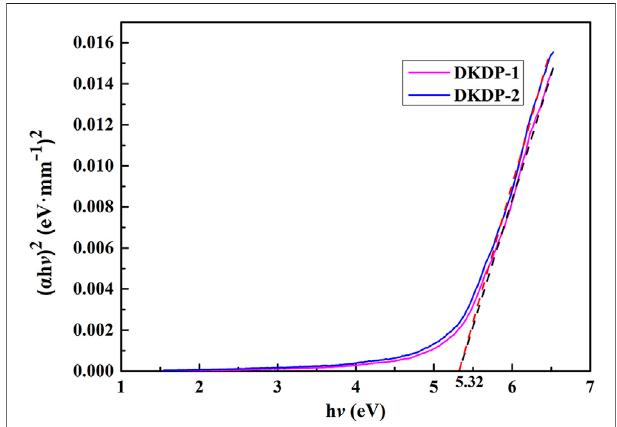
FIGURE2| Cuttingschematicdiagramofsamples(navybluelinesshow the pyramid – prism